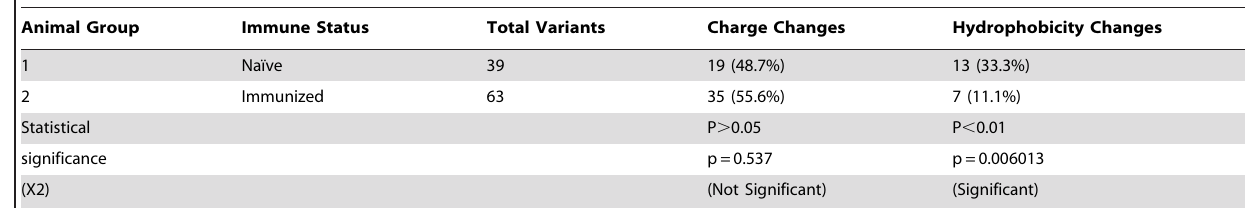
Table 2. Analysis of amino acids in HA variants.